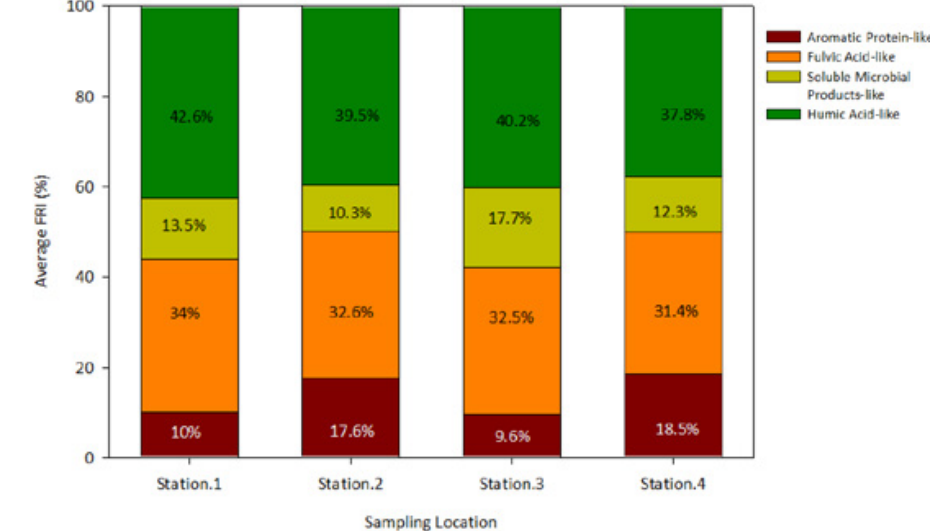
Fig. 6: FRI distribution of fractionated organic matter from the various river segment